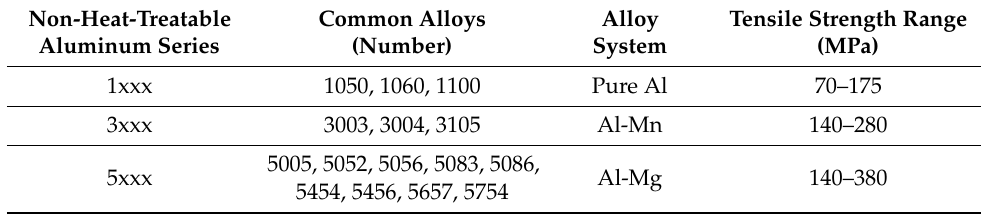
Figure 1. Schematic of the FSW Process [21]. Reprinted from: Quantitative wear analysis of H13 steel tool during friction stir welding of Cu-0.8%Cr-0.1%Zr alloy, Wear 378 (2017): 82–89. Sahlot, Pankaj, Kaushal Jha, G. K. Dey, and Amit Arora, Copyright 2017, with permission from Elsevier. Table 1. Non-heat-treatable Al alloys [17,18] .